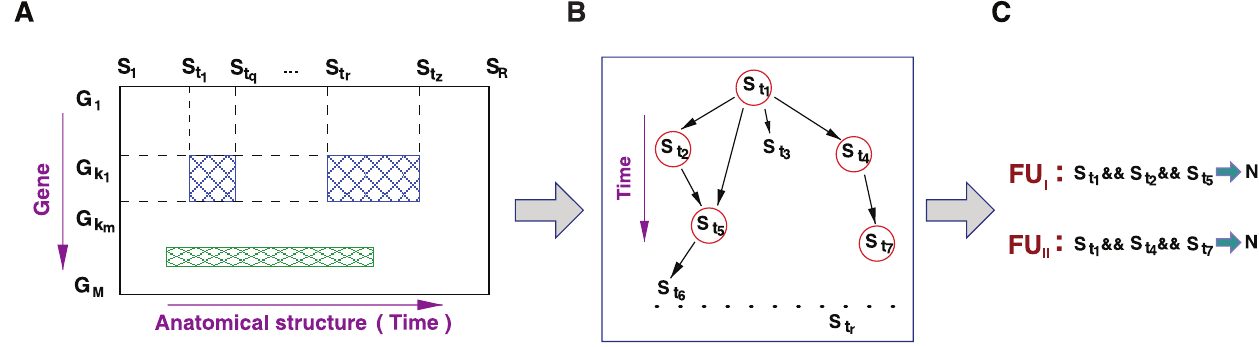
Figure 5. Construction of a Functional Unit (A) Results of the cluster analysis reported by Tomancak et al. [9] with the binary in situ gene expression matrix. This matrix constructed by parsing the BGDP Expression Patterns database allows the identification of groups of anatomical structures involved in key developmental processes